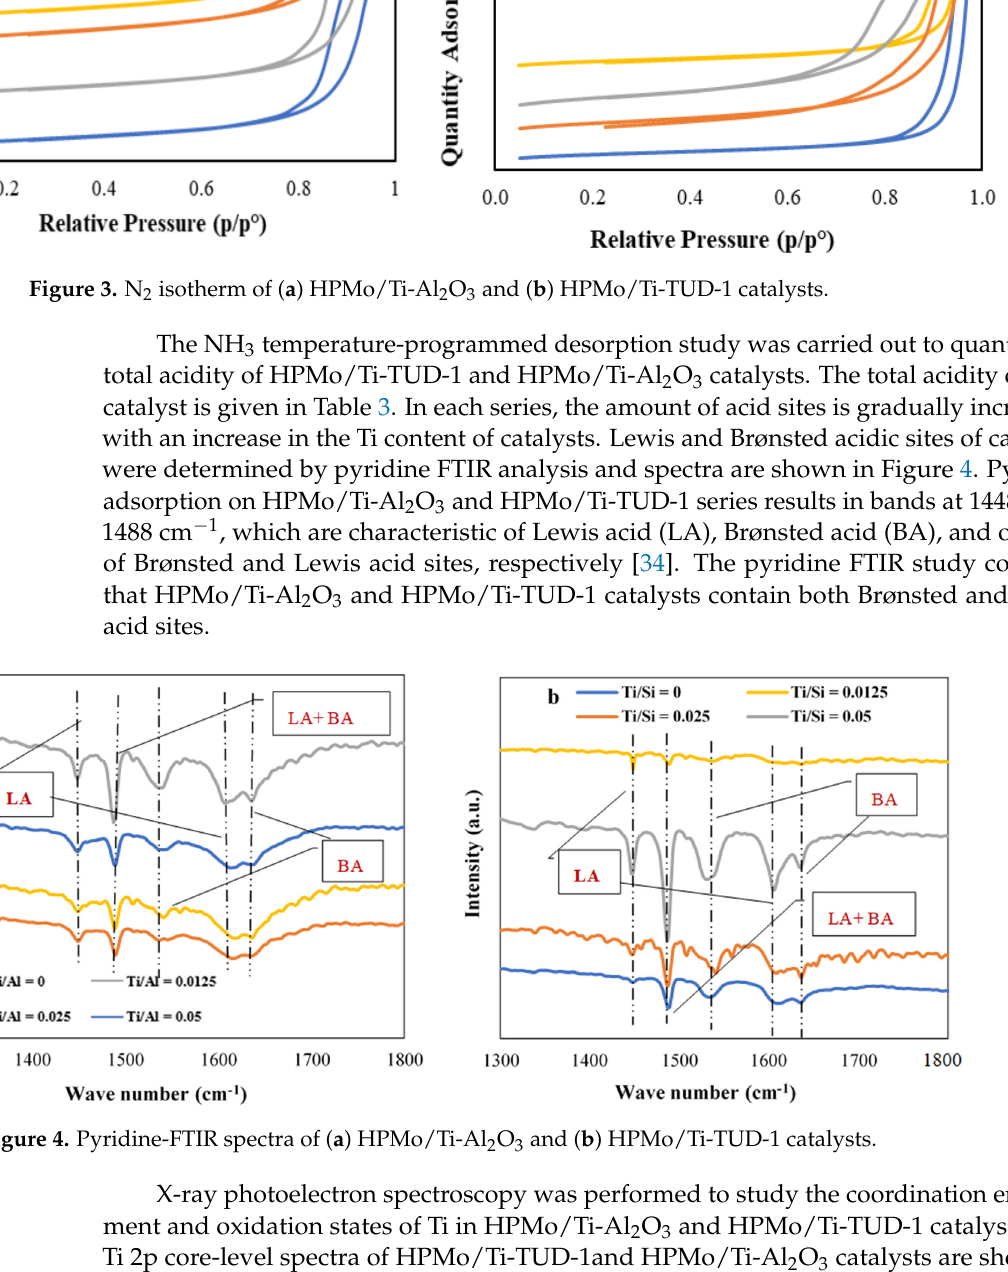
Figure 4. Pyridine-FTIR spectra of ( a ) HPMo/Ti-Al 2 O 3 and ( b ) HPMo/Ti-TUD-1 catalysts. X-ray photoelectron spectroscopy was performed to study the coordination environ- ment and oxidation states of Ti in HPMo/Ti-Al 2 O 3 and HPMo/Ti-TUD-1 catalysts. The Ti 2p core-level spectra of HPMo/Ti-TUD-1and HPMo/Ti-Al 2 O 3 catalysts are shown in Figure 5. Generally, the framework and non-framework Ti species exist in the tetrahe- dral and octahedral coordination, respectively. The binding energies at 458.4 and 464 eV are associated with 2p 3/2 and 2p 1/2 orbital spin electrons of tetrahedral coordinated Ti (IV) species [37]. The intensities of these peaks are increasing with the Ti loading and appear predominant for the Ti/Si(Al) ratio of 0.05. The XPS result confirms the successful substitution of Ti in the Al 2 O 3 and TUD-1